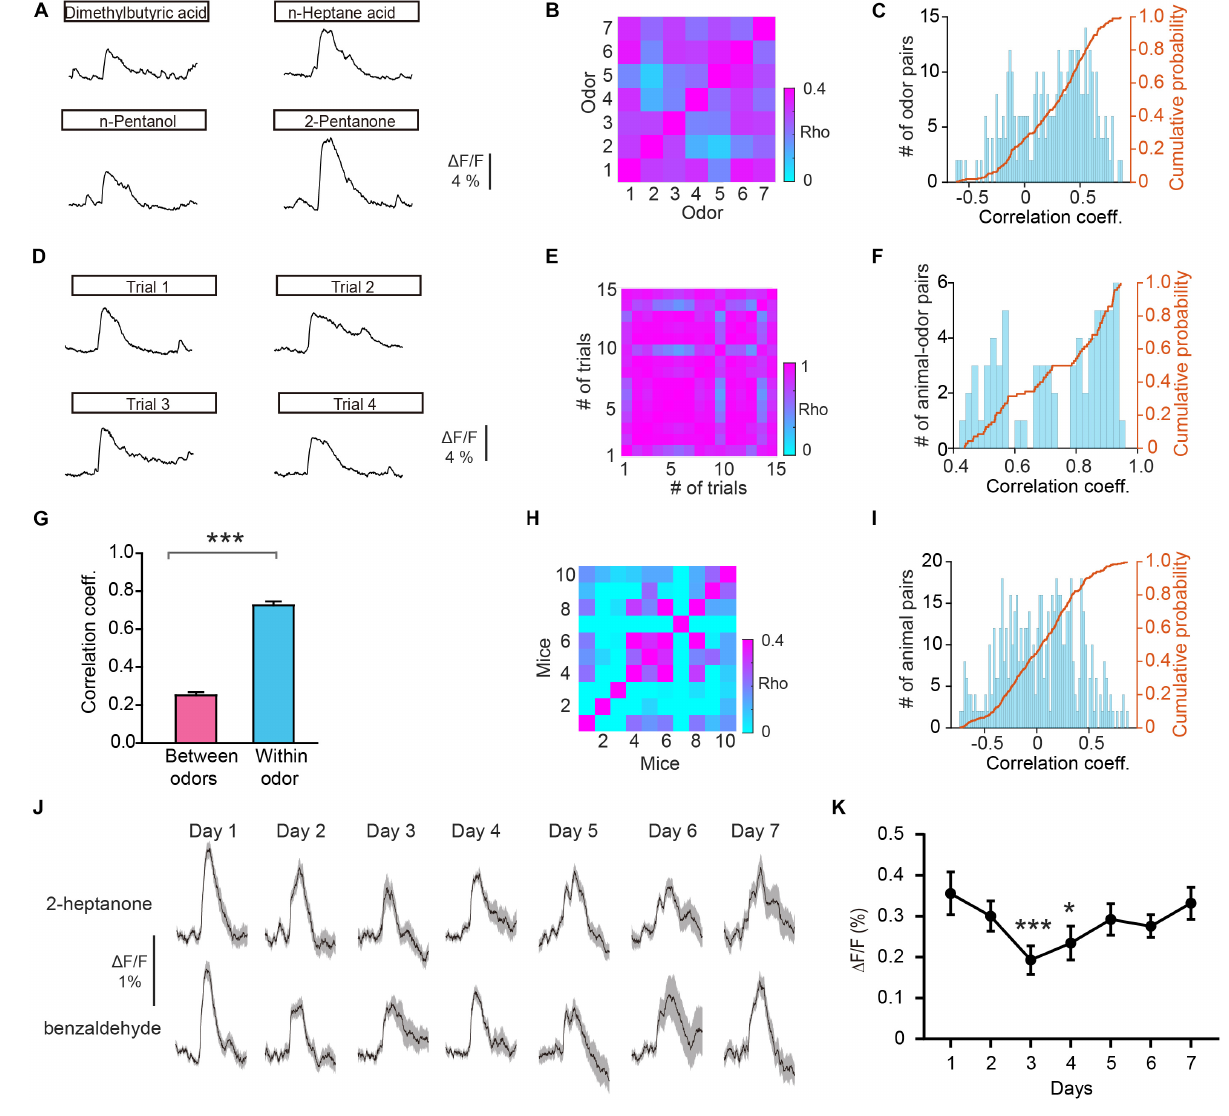
FIGURE 3 | Odor responses differ between odors. (A) Odor responses evoked by four odorants in an individual mouse. (B,C) Heat map (B) , histograms (C) , and cumulative probability (C) of the correlation coefficients for the (cid:49) F/F induced by different odorants. (D) Odor responses evoked by the same odorant (n-Pentanol) in different trials in an individual mouse. (E,F) Heat map (E) , histograms (F) , and cumulative probability (F) of the correlation coefficients for the (cid:49) F/F from different trials with the same odorant. (G) Comparison of the correlation coefficients for the “between odors” and “within odor” conditions (Mann-Whitney test, U = 2706, P < 0.0001). (H,I) Heat map (H) , histograms (I) , and cumulative probability (I) of the correlation coefficients for the (cid:49) F/F induced by the same odor in different animals. (J) Representative GC odor responses over 7 days of passive exposure. (K) Averaged (cid:49) F/F over days. [Friedman test: χ 2 (6, 138) = 26.7, P = 0.000164, odor 1 versus odor 4, P = 5.96 × 10 - 5 , odor 4 versus odor 7, P = 0.0281]. * P < 0.05, *** P <